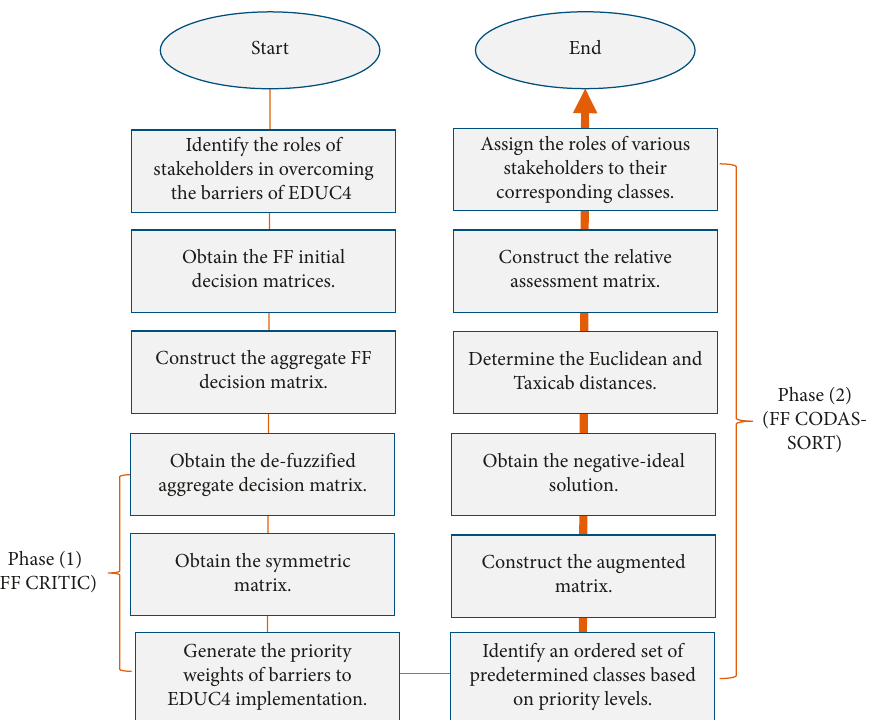
Figure 2: The methodological